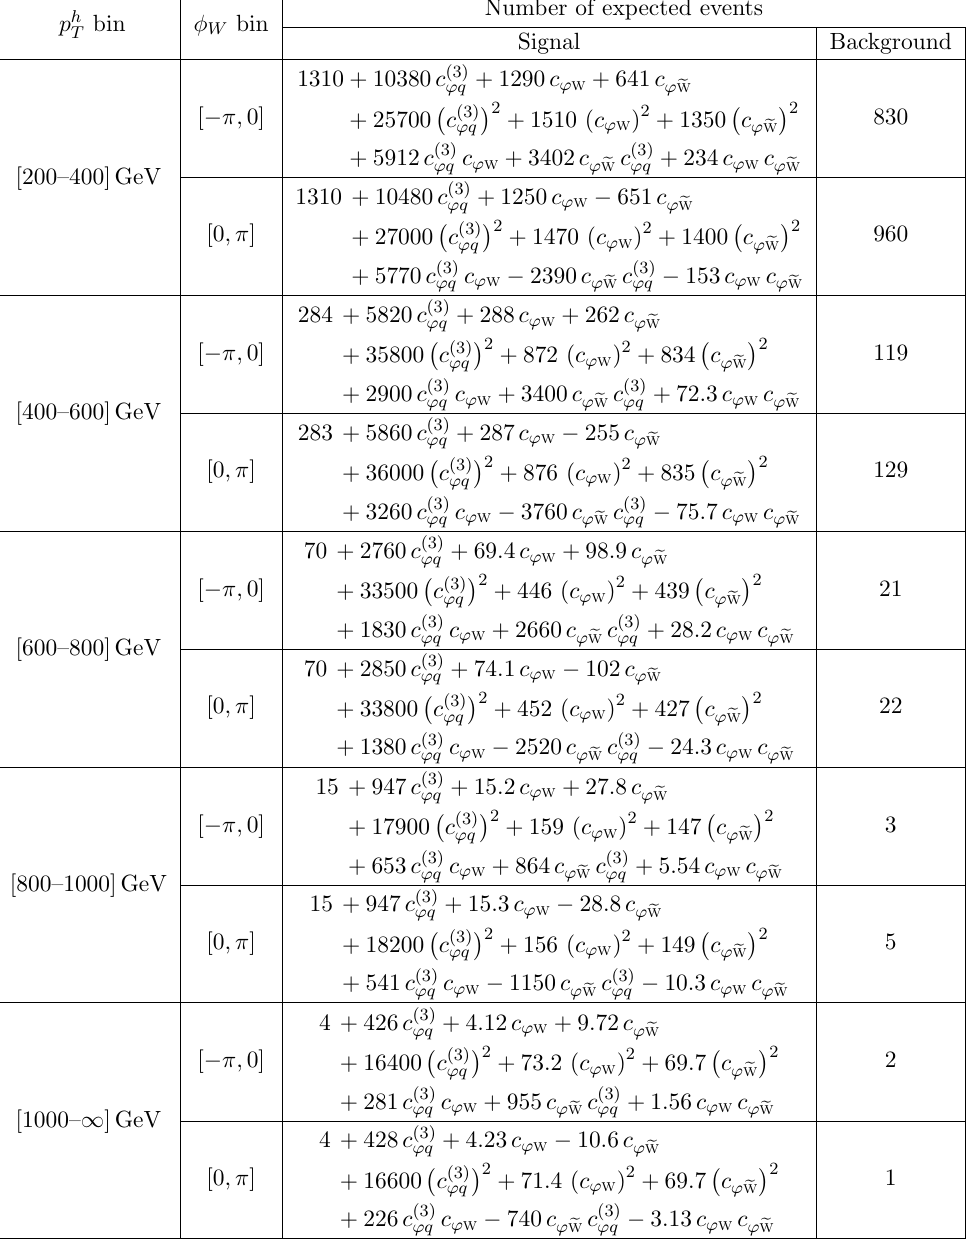
Table 9 . Number of expected signal and background events at FCC-hh with 30 ab (cid:0) 1 . For the signal, it is given as a function of the Wilson coe(cid:14)cients (with (cid:3) = 1 TeV). Notice that the coe(cid:14)cients have errors of order few percent due to statistical (cid:13)uctuations. The contribution of Wjj to the background events is neglected.